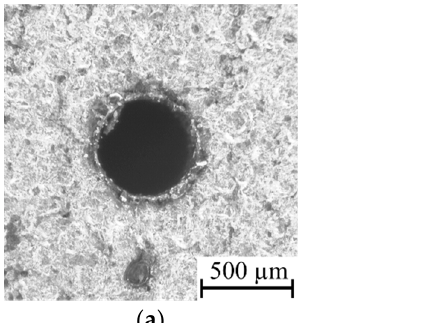
Figure 16. The impact of various values of the current amplitude on: ( a ) the drilling speed v ; ( b ) the hole’s aspect ratio AR .